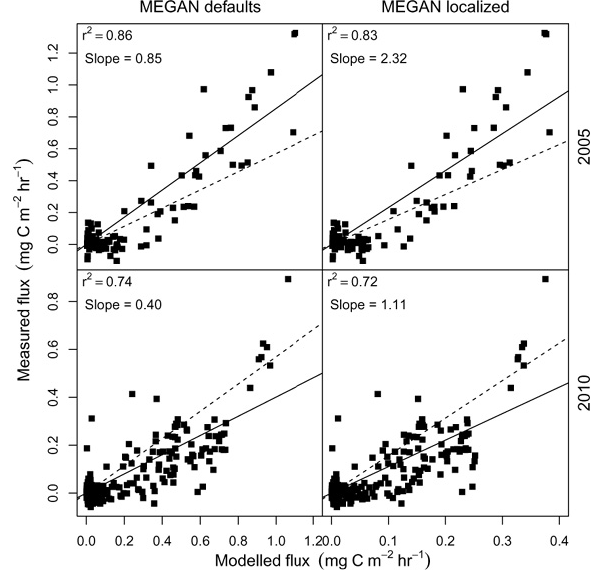
Fig. 6. Comparison of whole-ecosystem isoprene fluxes mea- sured to the MEGAN emission model. Model predictions of the Emission canopy are on the x-axis and the measurements of whole- system isoprene emissions are on the y-axis. Left-hand panels: output using the default parameter values from MEGAN’s global database. Right-hand panels: output using parameter values esti- mated for the moist acidic tundra ecosystem. The solid line is the linear fit with a zero intercept between the model and the observa- tions for each individual year. The dashed line is the same fit for both years (EC05 and EC10) combined. The statistics for the com- bined fit with MEGAN defaults (two left-hand panels) are r 2 = 0.72 and slope = 0.70 and with MEGAN localized (two right-hand pan- els) are r 2 = 0.70 and slope